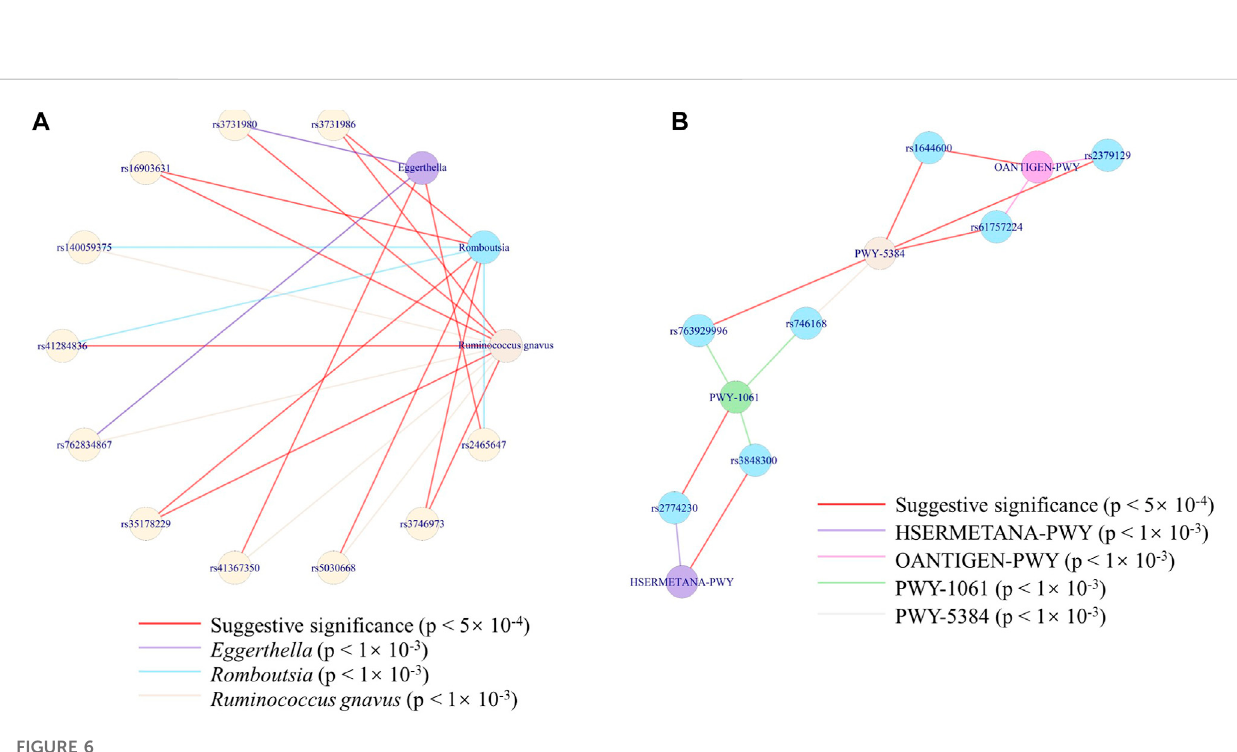
FIGURE 6 Network of the associations among SNPs and the features. (A) Network of the associations among three species with 12 genes at 13 loci. (B) Network of the associations among four pathways with six